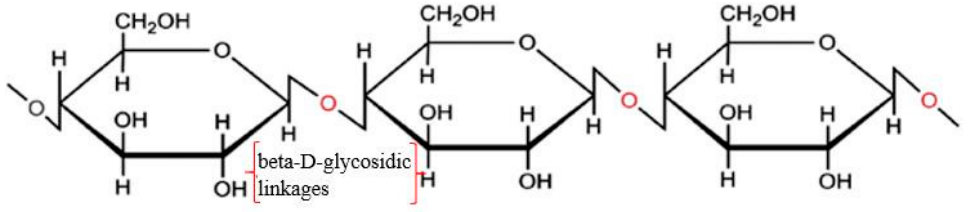
Figure 1. Structure of cellulose. Reproduced from [32], with permission from Elsevier, 2015.